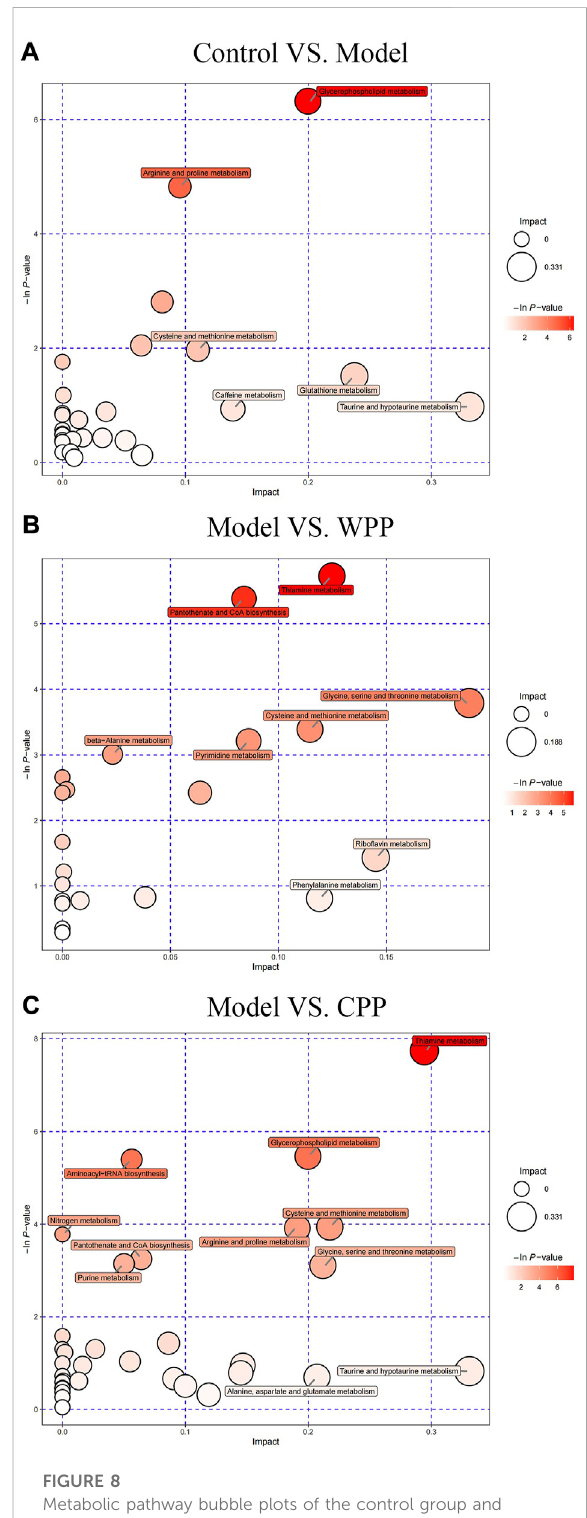
FIGURE 8 Metabolic pathway bubble plots of the control group and modelgroup (A) ,themodelgroupandWPP-treatedgroup(40 μ g/ ml) (B) , and the model group and CPP-treated group (40 μ g/ml) (C) . The X -axis and Y -axis represent the impact and − ln p values,